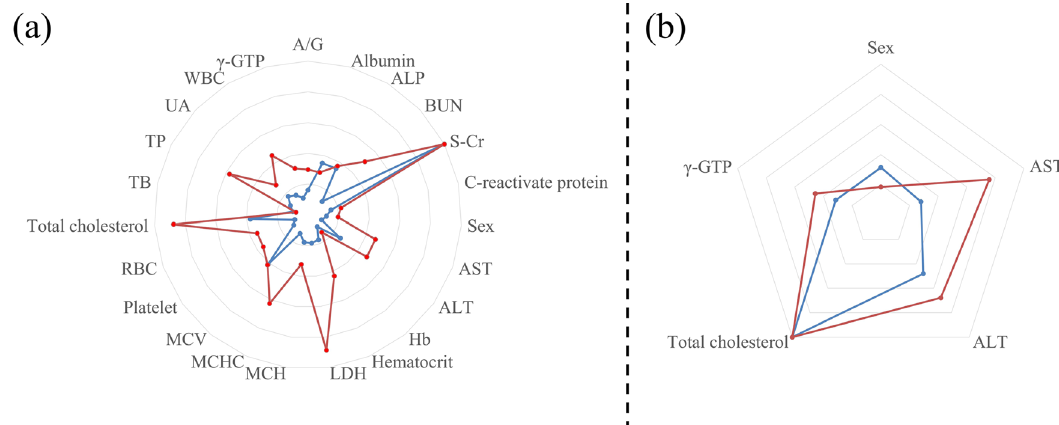
Fig. 1 Comparison of feature importance between hyperthyroidism and hypothyroidism classi fi cation models. The blue line shows the feature importance of the hyperthyroidism classi fi cation model, while the red line shows that of the hypothyroidism classi fi cation model. a The fi ve most important features in the hyperthyroidism model using Feature set 1 were S-Cr, MCV, total cholesterol, ALP, and albumin. The fi ve most important features in the hypothyroidism model using Feature set 1 were S-Cr, LDH, total cholesterol, MCHC, and TP. b Among the fi ve laboratory tests used as features, total cholesterol exhibited the highest feature importance in both the hyperthyroidism and hypothyroidism models. The second and third most important features were ALT and sex in the hyperthyroidism model, while those in the hypothyroidism model were AST and ALT. AST denotes aminotransferase, ALT: alanine aminotransferase, γ -GTP: gamma-glutamyl transpeptidase, RBC: red blood cell count, S-Cr: serum creatinine, ALP: alkaline phosphatase, UA: uric acid, LDH: lactic acid dehydr.ogenase, TP: total protein, BUN: blood urea nitrogen, A/G: albumin/globulin ratio, TB: total bilirubin, WBC: white blood count, Hb: hemoglobin, MCV: mean corpuscular volume, MCH: mean corpuscular hemoglobin, and MCHC: mean corpuscular hemoglobin concentration. Table 4 Evaluation results obtained without considering crosstalk. No.